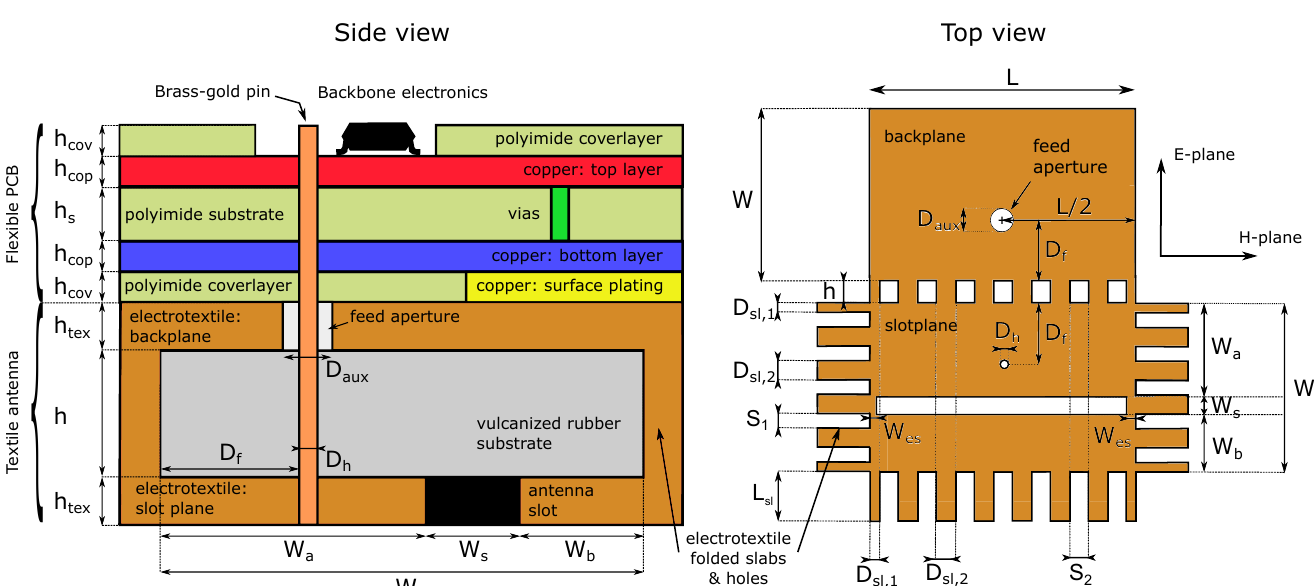
Figure 2. Stackup of the finished sensor node (side view, left) and shape of the unassembled electrotextile patch (top view, right). Dimensions: L = 56 mm, W = 34 mm, W a = 20 mm, W b = 10.5 mm, W s = 4.5 mm, D f = 15 mm, D aux = 5 mm, D h = 1 mm, D sl ,1 = 2 mm, D sl ,2 = 4 mm, S 1 = 2.8 mm, S 2 = 4 mm, L sl = 10 mm, W es = 1 mm, h = 4 mm, h tex = 0.15 mm, h cov = 25 µ m, h cop = 16 µ m, and h s = 50 µ m. This model is based on the design from [26], accommodating a different feed pin